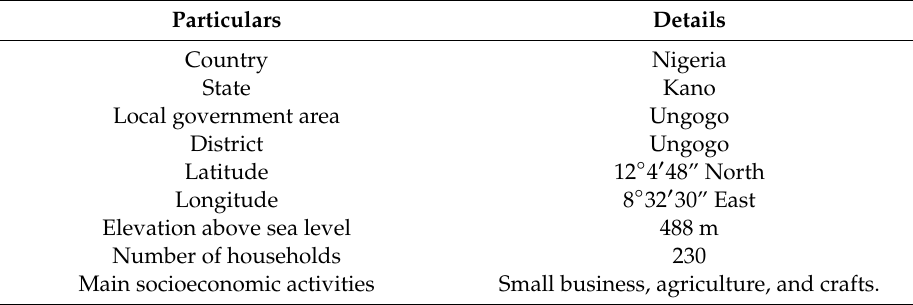
Figure 3. The spatial location of the area of study (Fanisau). Table 1. Background information on Fanisau.